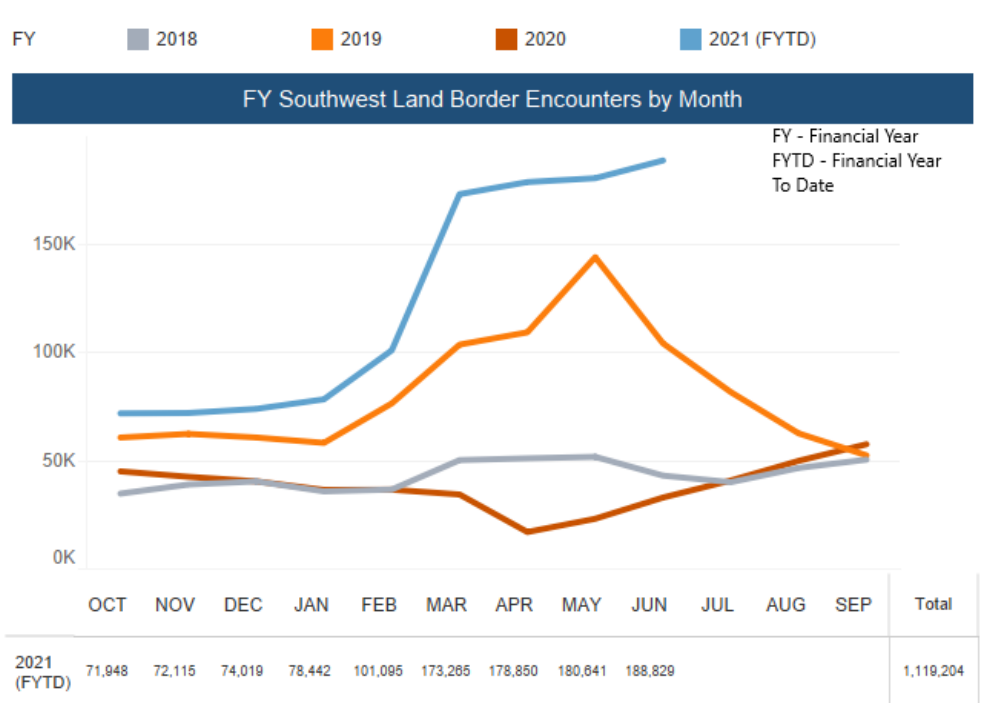
Figure 5. Encounters of Unaccompanied Minors by the U.S. Border Patrol along the South-West Border (Source: Reproduced from the U.S. Customs and Border Protection) [33].